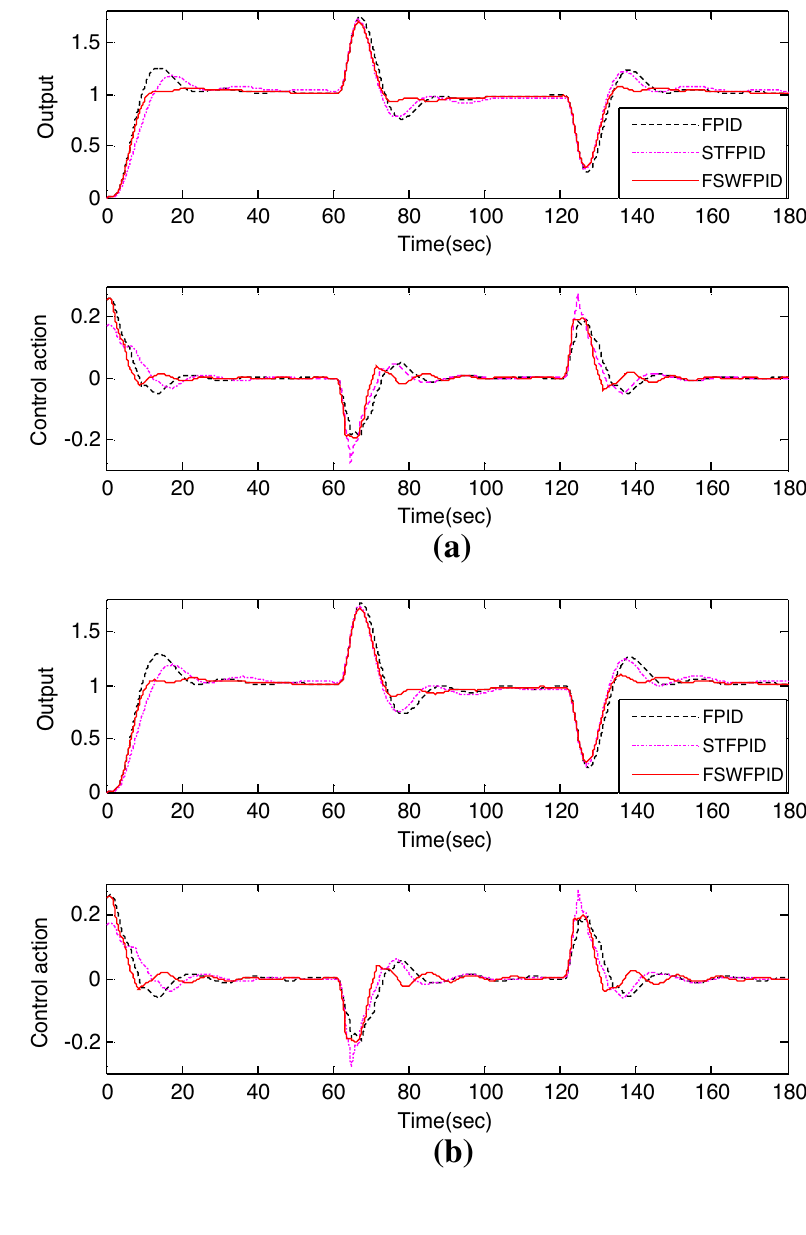
Fig. 13 Responses and control actions for Model III using 25 rules during set point response and with load variation for a L = 0.05 s, b L = 0.7 s